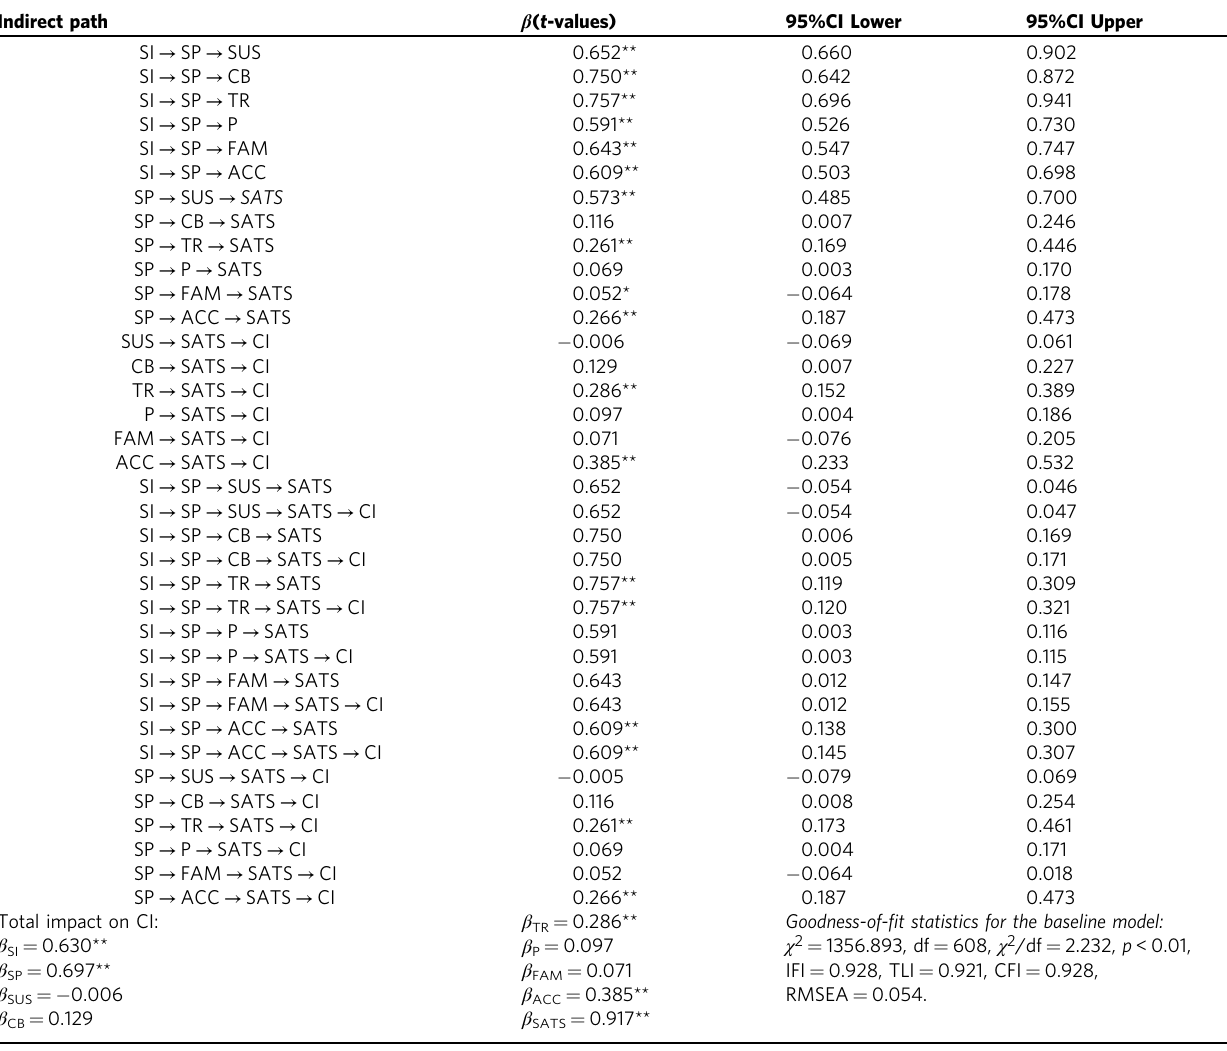
Table 3 Indirect and total effect assessment. Indirect